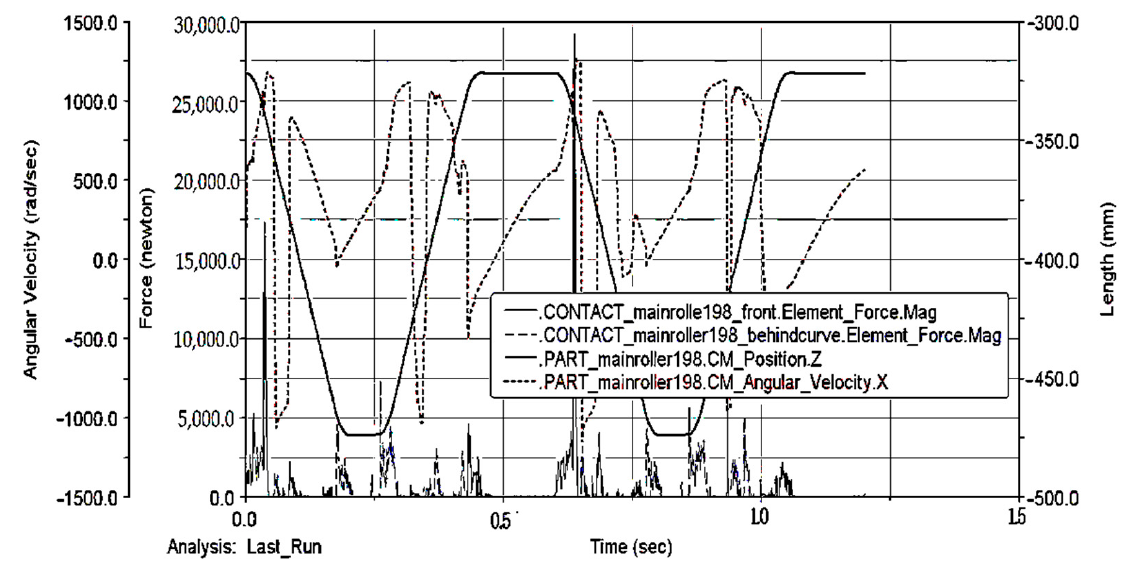
Figure 14. The motion change curve in the main roller with the consideration of gap and no recoil. The dynamic characteristics of the main roller of the gap secondary cam mechanism are shown in Figures 13 and 14: the red dashed line represents the angular speed of the main roller, the solid black line represents the position of the main roller, the blue dotted line represents the change in the contact force of the main roller and the rear end of the curve groove, and the black dotted line represents the contact force of the change in the front end of the main roller. It can be seen that, because of the existence of the gap, the main roller and the two ends occur. After the firing rate is stabilized, the automaton gradually tends towards the periodic movement. During an average cycle, the main roller meets the front end once, and the contact force of the main roller and the rear-end surface changes periodically. The main roller cannot meet the conditions required for pure rolling, so only translation motion can occur, and not rolling; the contact surface is a finite domain inside contact, and sliding friction occurs. Figure 15 illustrates the contact force variation of the front end and rear end of the cam slot curve with time t. The maximum value of the contact force exceeds 5000 N. The dotted line indicates the angular velocity of the main roller. The black line indicates the mass center of the main roller along the Z -axis between 475 mm and − 375 mm.